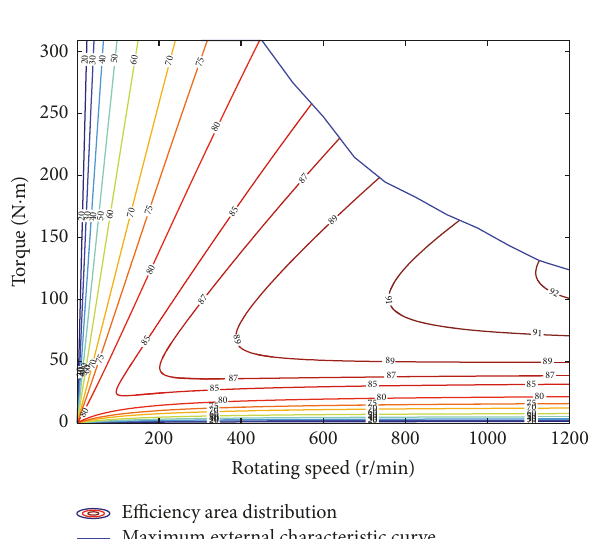
Figure 4: Drive motor efficiency MAP